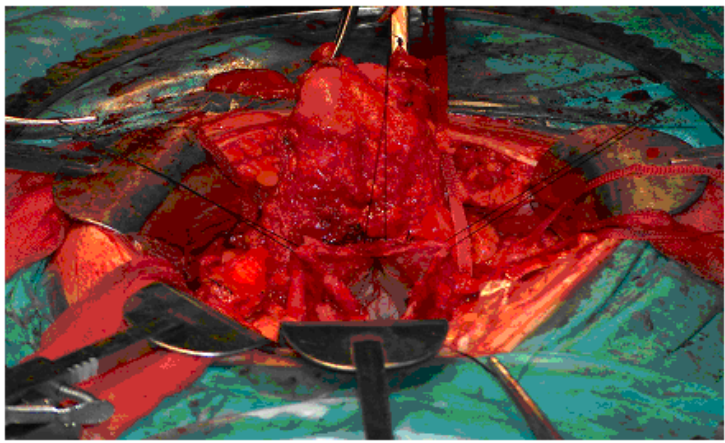
FIGURE 4 . The view of opened cyst after sterilization.